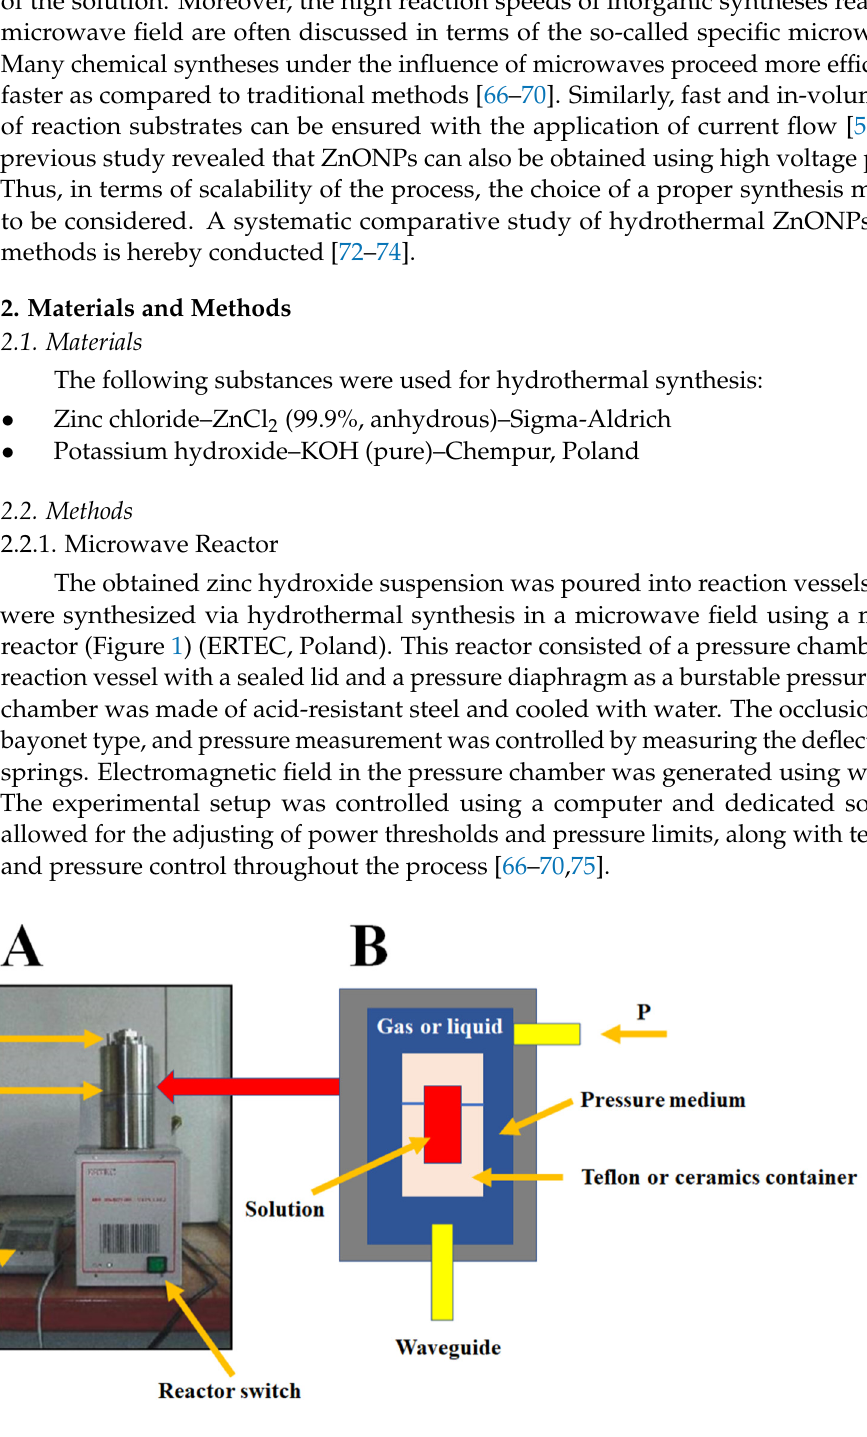
Figure 1. Microwave reactor: ( A ) overall view, ( B ) schematic.